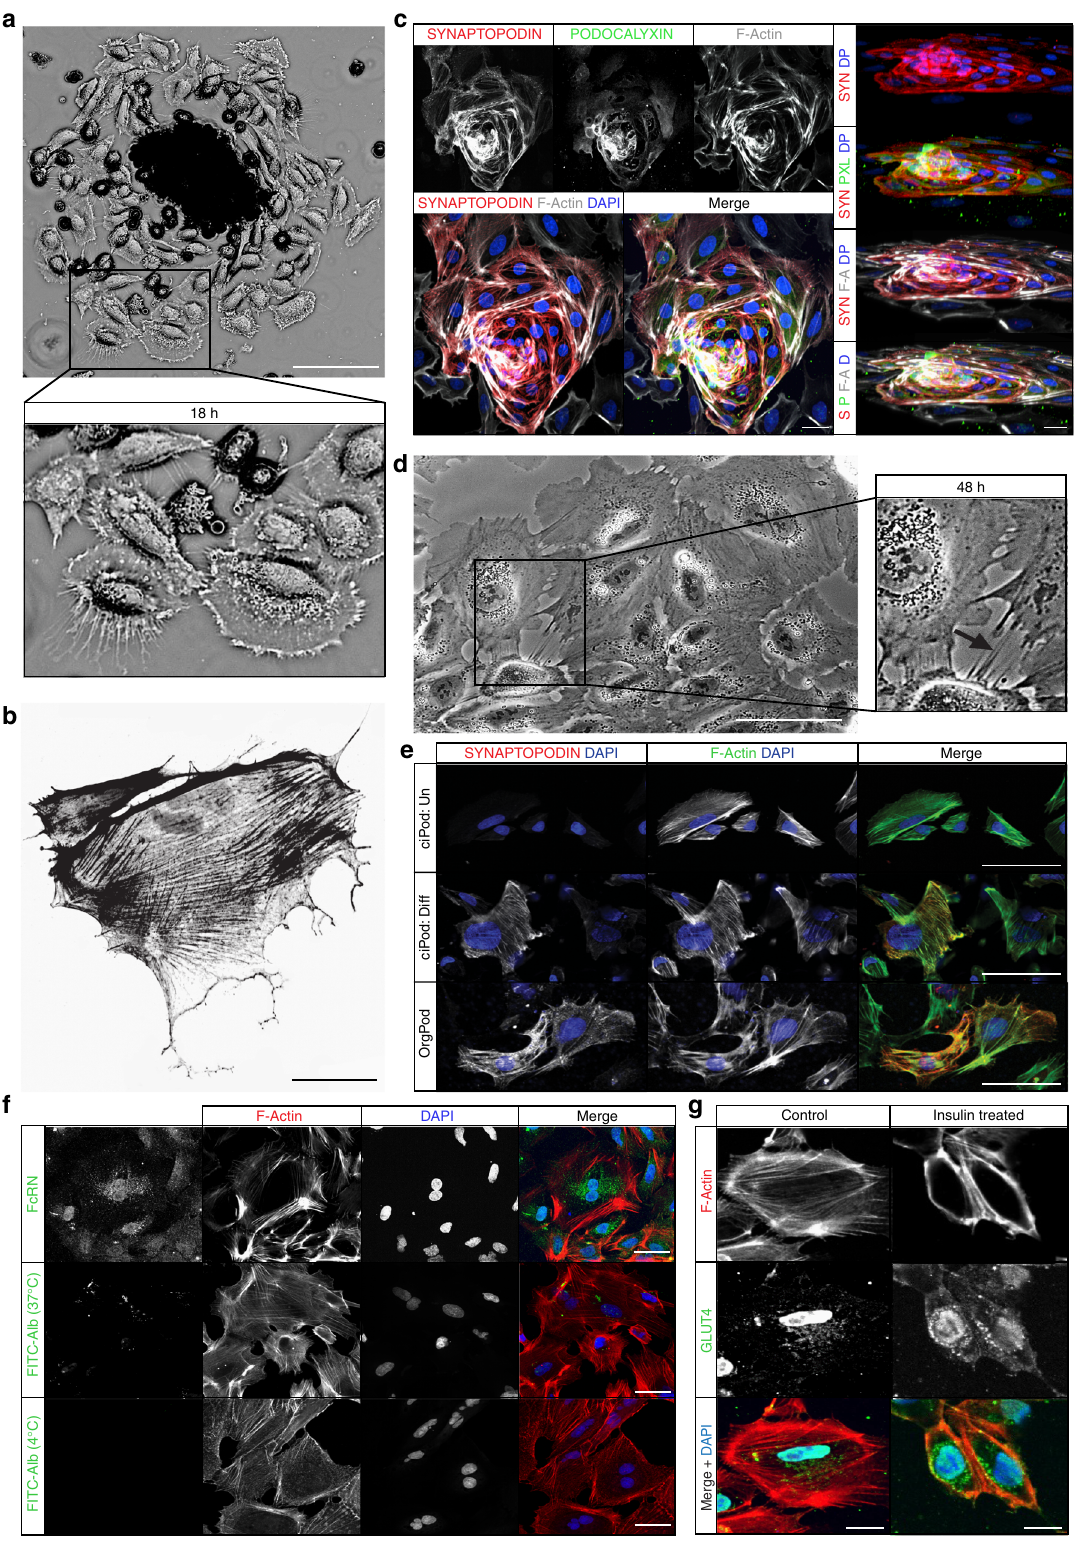
pro fi led undifferentiated iPSC lines (Supplementary Fig. 3A). While this may be feasible to characterise genes such as PODXL , which are expressed in undifferentiated iPSC (Supplementary Fig. 3B), this may not be a useful approach to characterising the role of genes only expressed in podocytes themselves. In